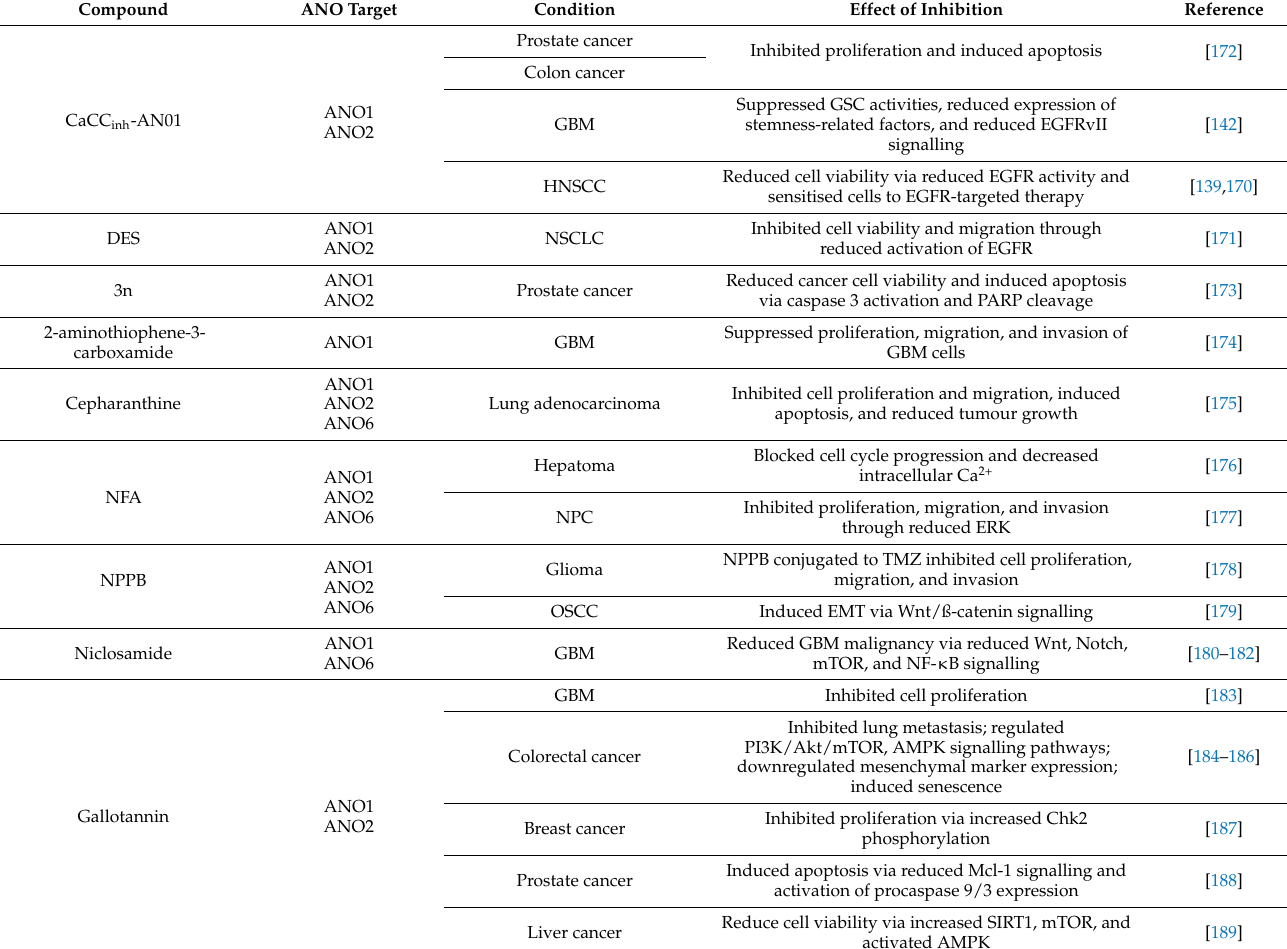
Table 3. ANO inhibitors in